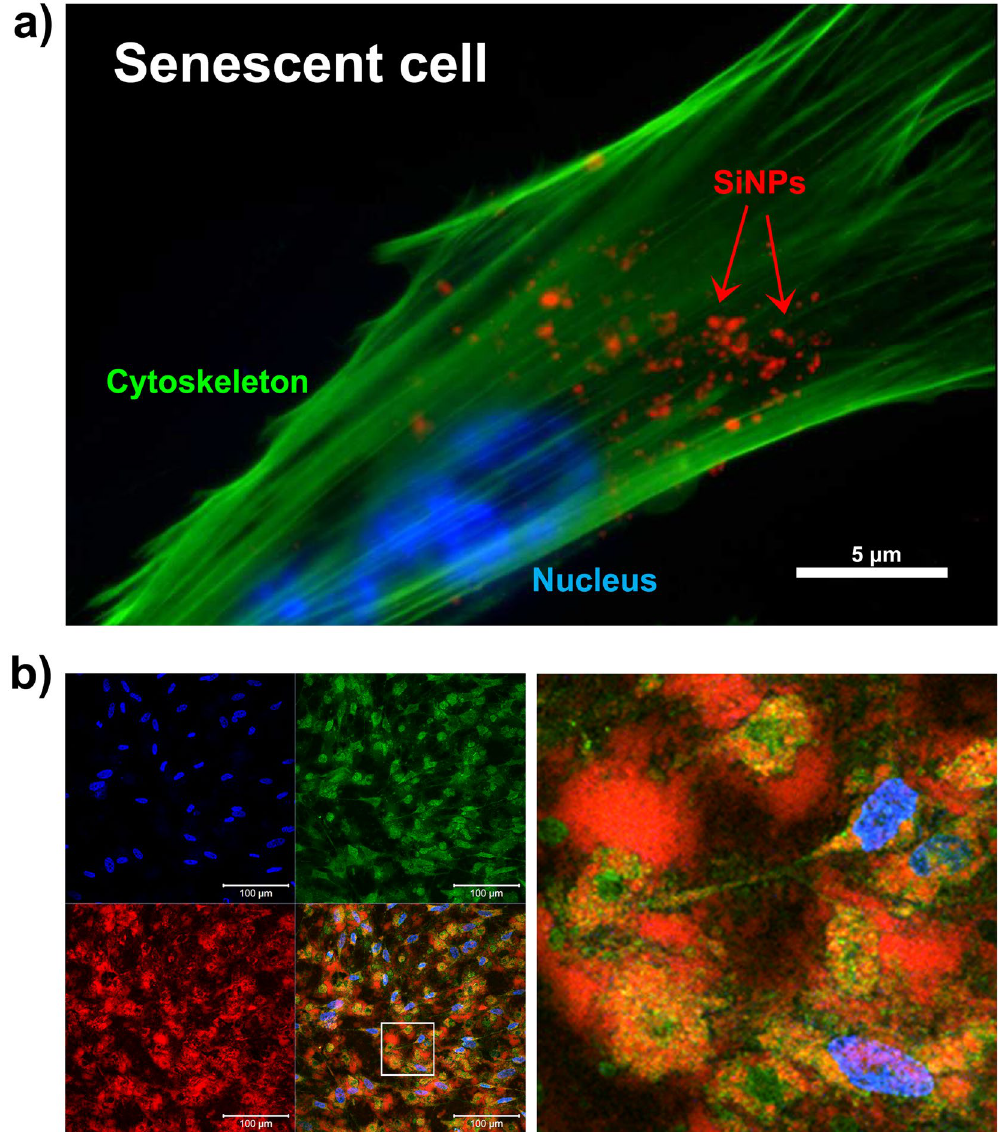
Figure 4. Intracellular accumulation of 200 nm SiNPs. ( a ) Senescent cells were incubated with 25 µg/ml of SiNPs for 80 min and imaged at 24 h using a fluorescence microscope. Staining with Hoechst 33342 (blue) and phalloidin-488 (green) shows the nucleus and cytoskeleton, respectively, in relation to internalized SiNPs (red). ( b ) Senescent cells were incubated with 166.66 µg/ml for 24 h and imaged by CLSM. Staining with Hoechst 33342 (blue) and conconavalin A (green) shows the nucleus and cell membranes, respectively, in relation to SiNPs (red). The right panel is a magnified region from the square area marked in the left